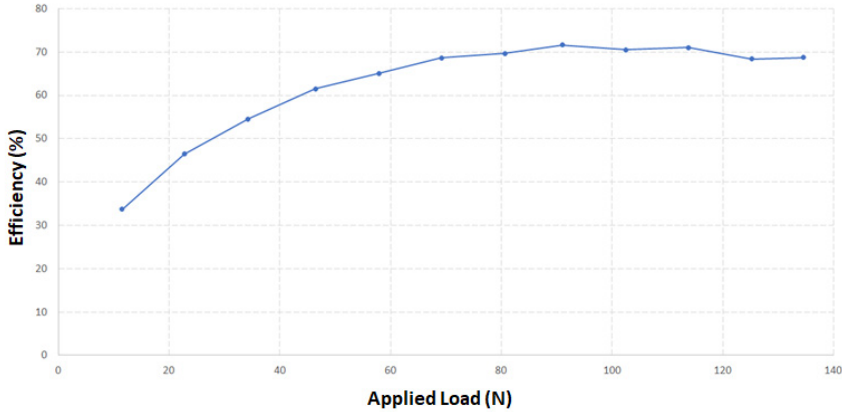
Figure 7. Mechanical efficiency of the B-SALD prototype under different levels of applied load.